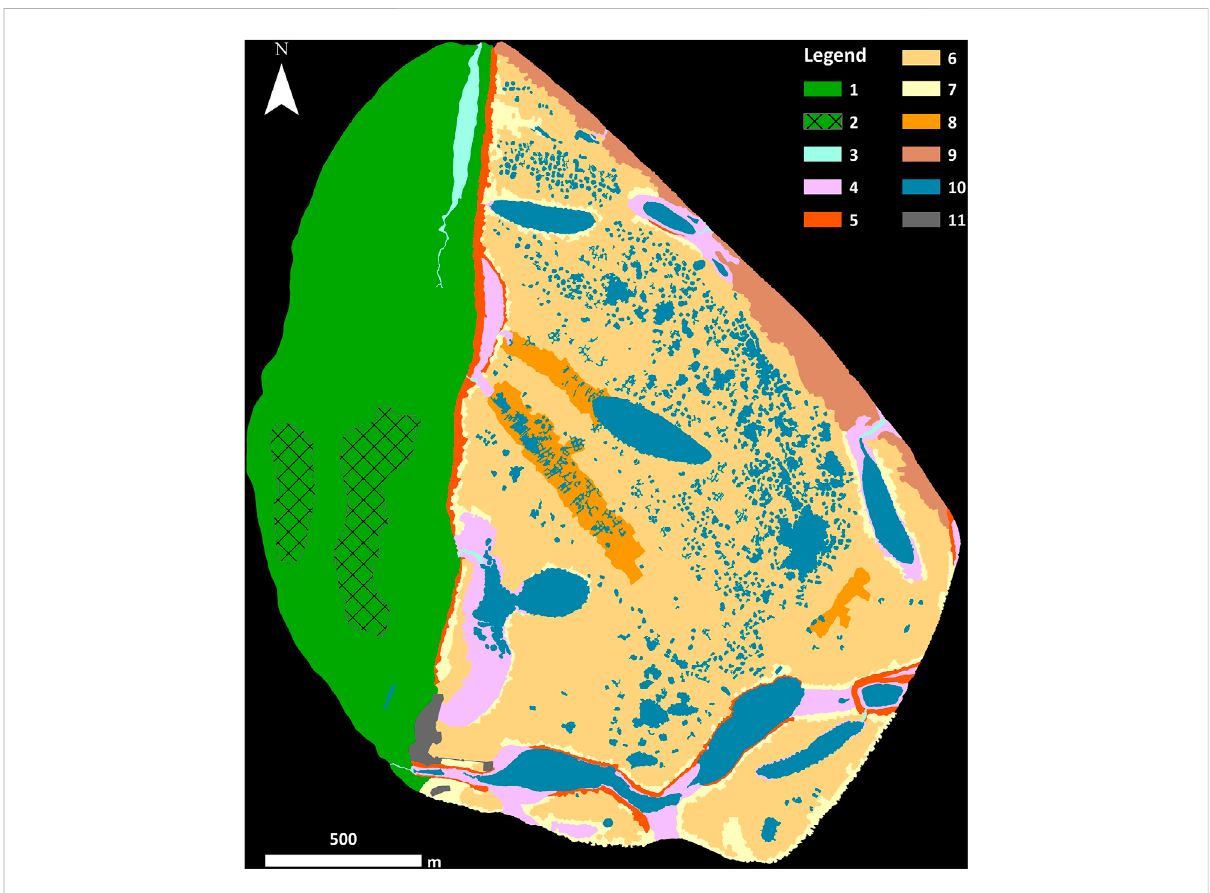
FIGURE 3 Soil-geomorphological map of the Samoylov isl., Lena River Delta. Scale Mapping units are explained in Table